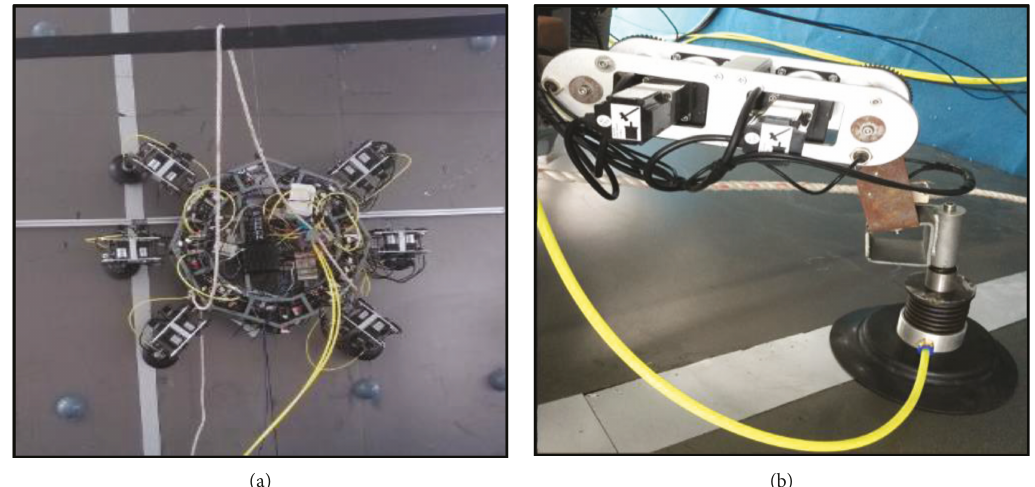
Figure 18: (a) The prototype of the wall-climbing hexapod robot. (b) The structure of one leg of the wall-climbing hexapod robot [31].